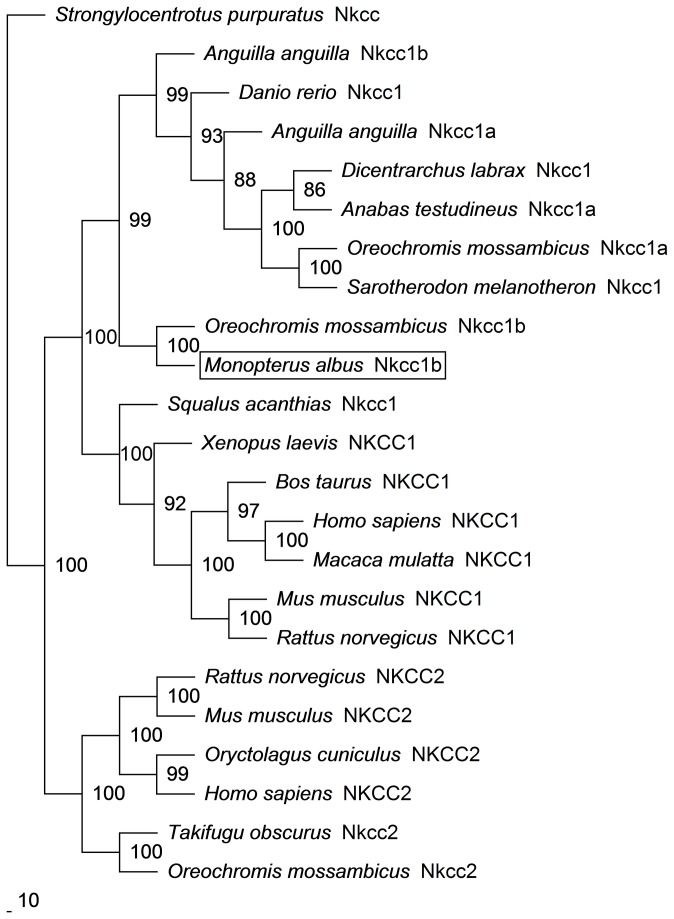
Phylogenetic analysis of Na+:K+:2Cl- cotransporter 1b (Nkcc1b) from the brain of

Monopterus

albus
.A phylogenetic tree to illustrate the relationship between Nkcc1b from the brain of M. albus and Nkcc/NKCC of selected vertebrate species. Numbers presented at each branch point represent bootstrap values from 100 replicates.

Strongylocentrotuspurpurtus

 Nkcc is used as the outgroup for the phylogenetic tree for Nkcc.